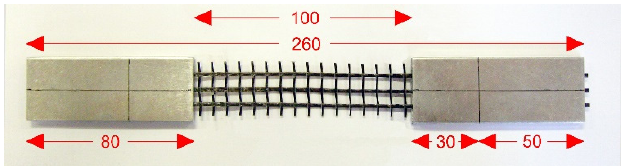
Figure 3. Basalt samples equipped with aluminium tabs.